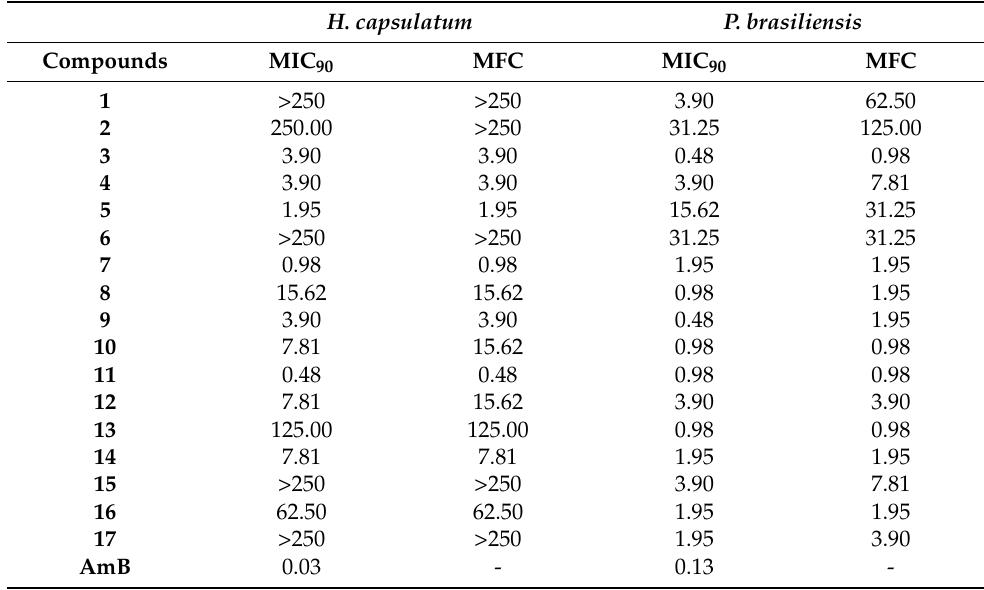
Table 2. Minimum inhibitory and fungicidal concentration values ( µ g/mL) of the 17 nitrofuran derivatives against H. capsulatum and P. brasiliensis